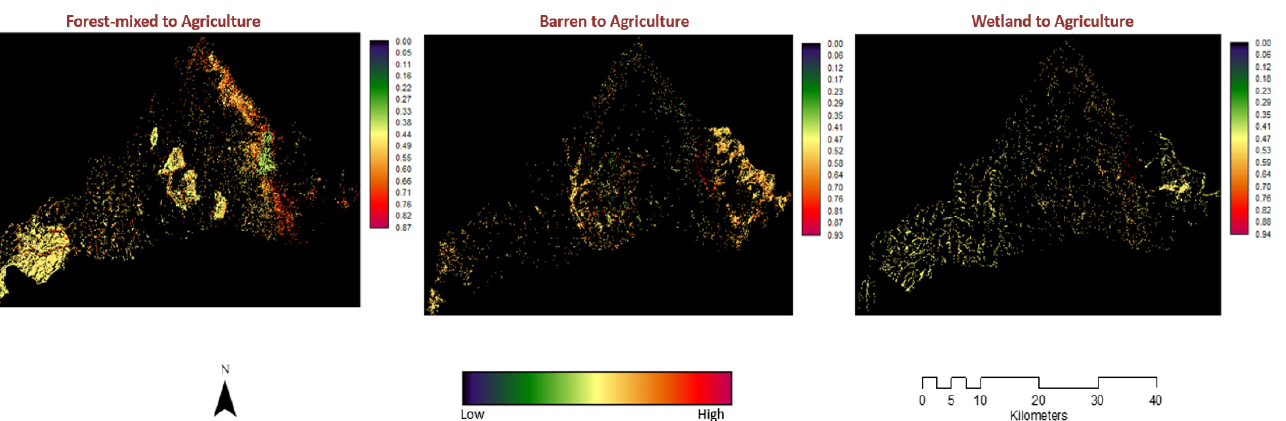
Figure 9. Land-Cover Transition Potentials (Probabilities): Ntcheu District. MLP-Markov chain modeling was used to predict land use change by 2050 using drivers of observed past change along with the probability of change at past and current time stamps of land cover to model future land-cover maps. By 2050 there is a high prob- ability (80%) that most of Dedza land will be agriculture (see bold values in Table 10), while Ntcheu has a lower probability of 43%. Moderate to high probabilities were ob- served for conversion to built-up (from agriculture) at 72%, to barren at 66%, and to forest- mixed at 48%. Ntcheu’s (italic values in Table 10) likelihood of conversion from other clas- ses to agriculture, built-up, shrub-woodland, barren and wetland is 30% or above, while the transition from forest-mixed is slightly lower at 26%. There are slight gains from forest to shrub-woodland at 28%, wetland to shrub-woodland (29%), and the “Other” class to shrub-woodland at 29%.